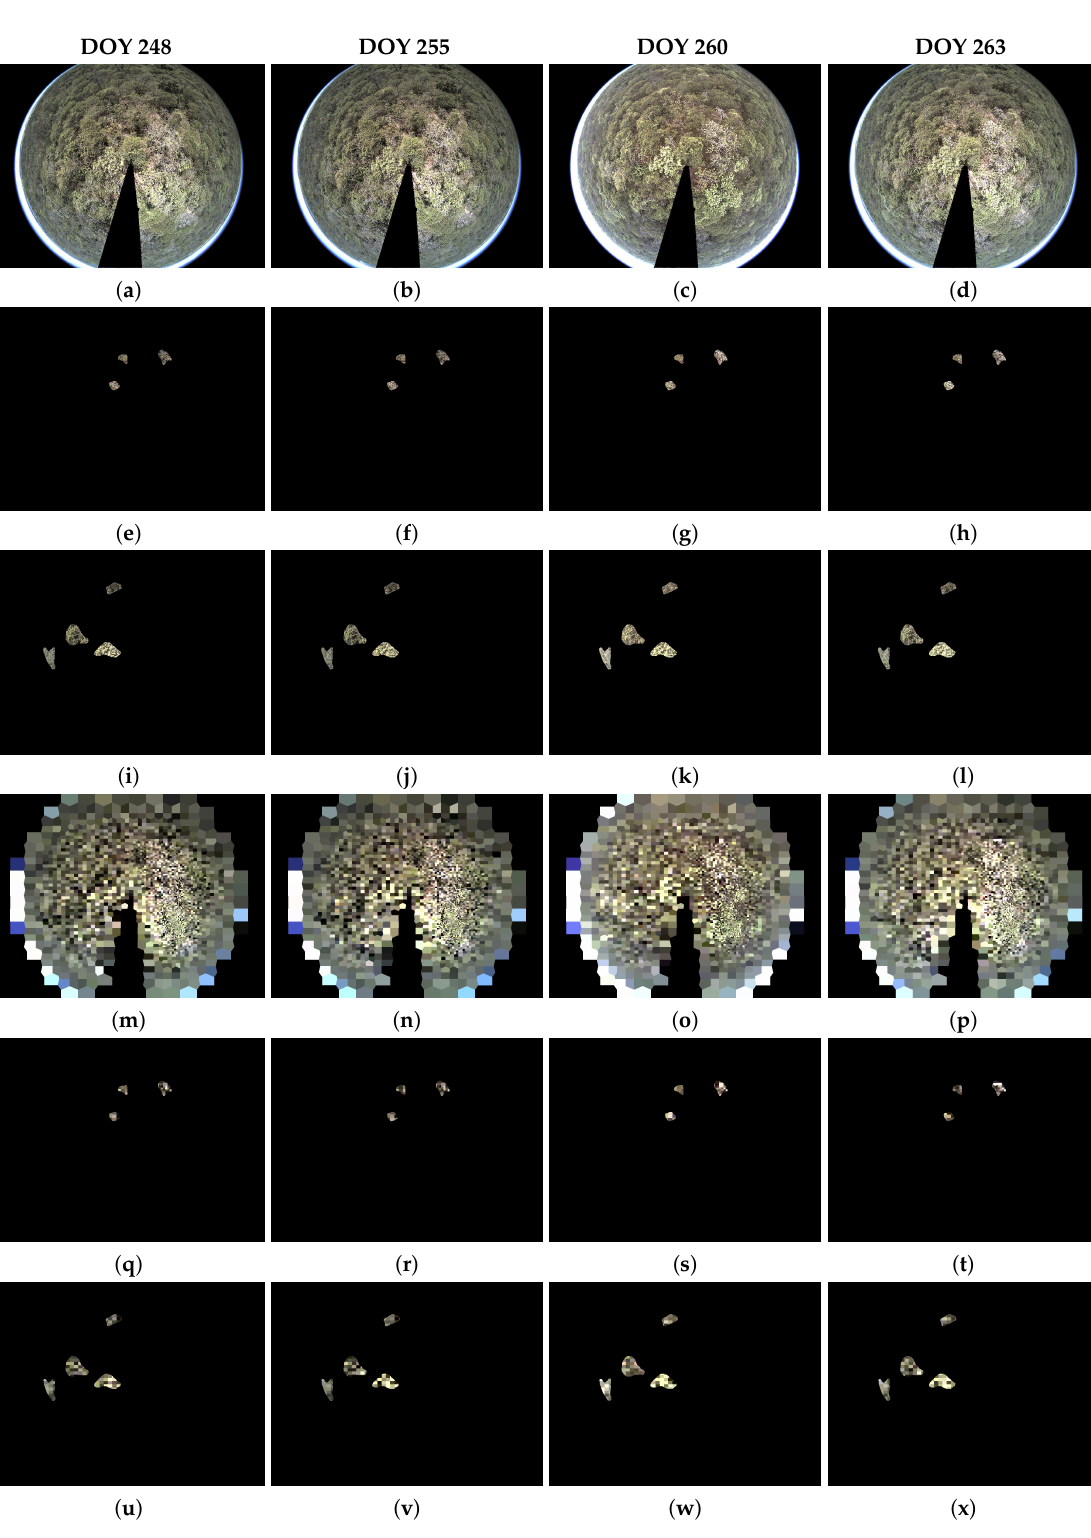
Figure 7. Examples of phenological images from 2013. The days of the year (DOYs) 248, 255, 260, and 263 are column-wise organized. Each row depicts the following: ( a – d ) original images; masked images containing only the ( e – h ) Aspidosperma tomentosum and ( i – l ) Caryocar brasiliensis individuals; ( m – p ) images reconstructed with the model for the 0110 pattern; and masked-reconstructed images containing only the ( q – t ) Aspidosperma tomentosum and ( u – x ) Caryocar brasiliensis